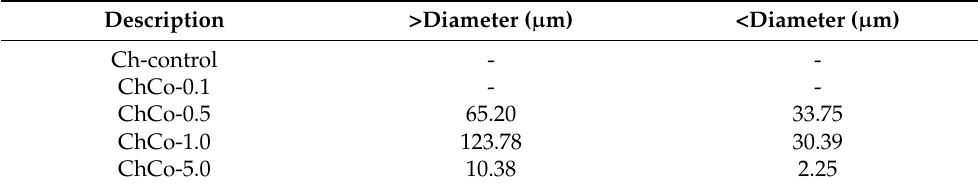
Figure 2. Membrane micrographs: ( a ) oil-free chitosan (Ch-control)180 magnification; ( b ) Oil-free chitosan (Ch-control) magnification of 9.08; ( c ) chitosan with 0.1% copaiba oil (ChCo-0.1) 180 magnification; ( d ) chitosan with 0.1% copaiba oil (ChCo-0.1) magnification of 9.08; ( e ) chitosan with 0.5% copaiba oil (ChCo-0.5) magnification of 180, ( f ) chitosan with 0.5% copaiba oil (ChCo-0.5) magnification of 9.08; ( g ) chitosan with 1.0% copaiba oil (ChCo-1)magnification of 180; ( h ) chitosan with 1.0% copaiba oil (ChCo-1)magnification of 180; ( i ) chitosan with 5.0% copaiba oil (ChCo-5) magnification of 180; ( j ) chitosan with 5.0% copaiba oil (ChCo-5) magnification of 9.08.